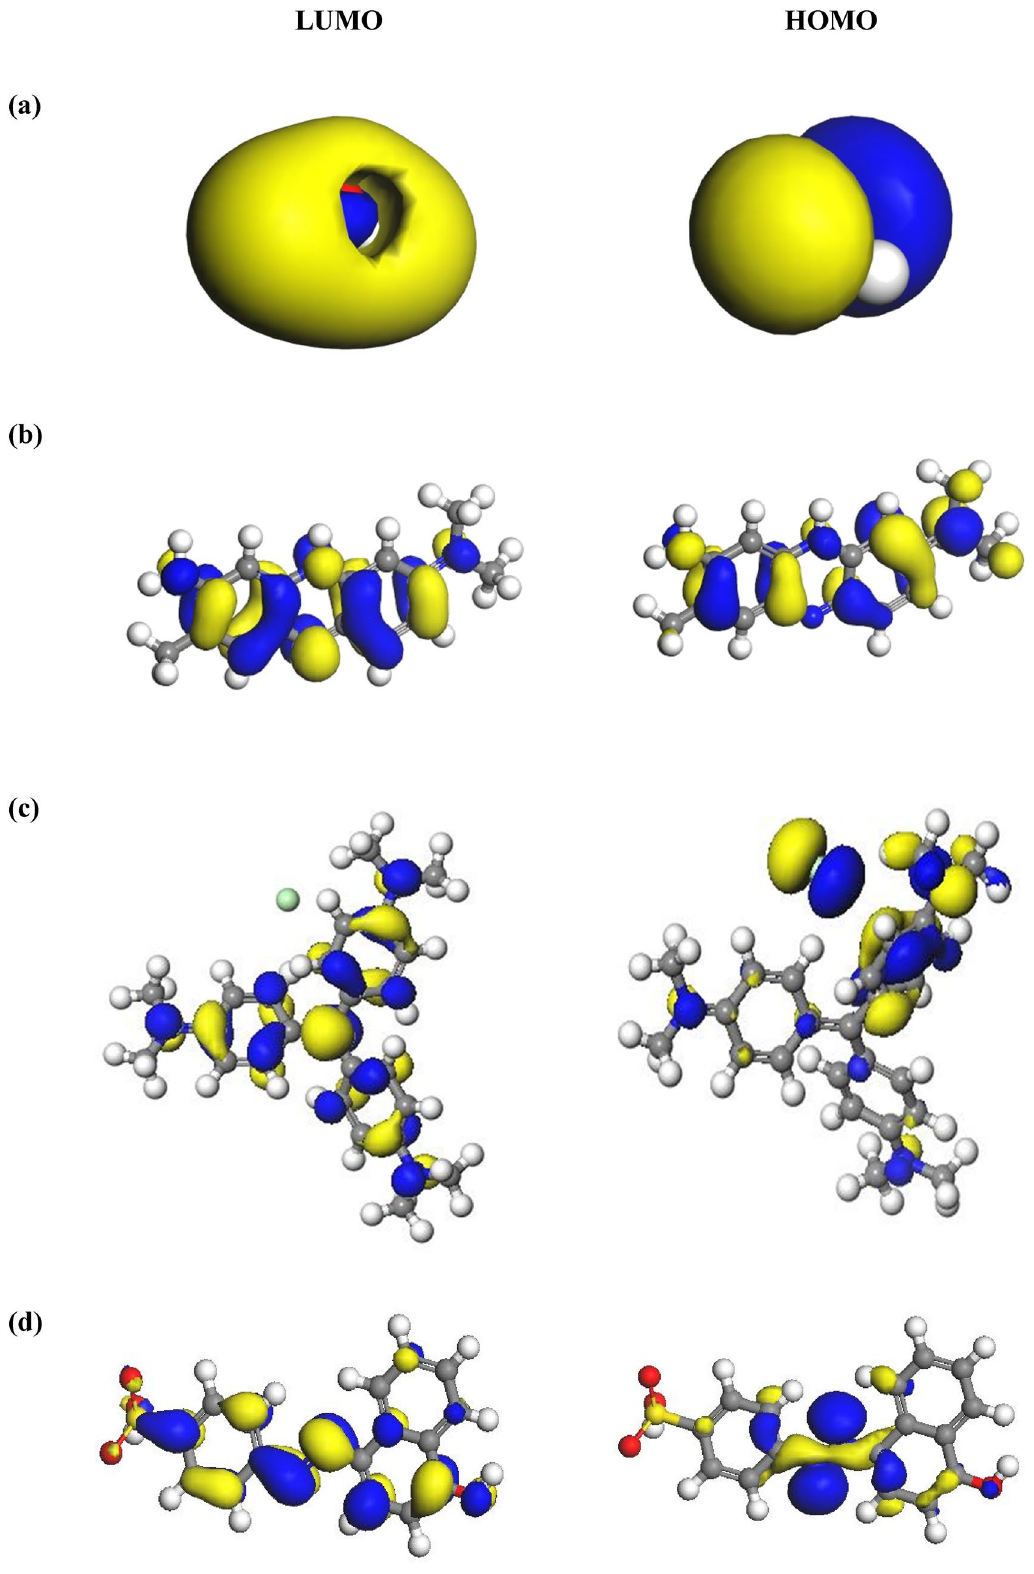
Figure 7. The HOMO and LUMO energy levels for water ( a ), NR ( b ), CV ( c ) and OII ( d ) dye